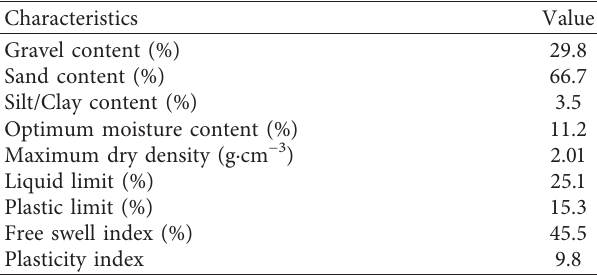
Table 1: Index properties of red bed soil used in this